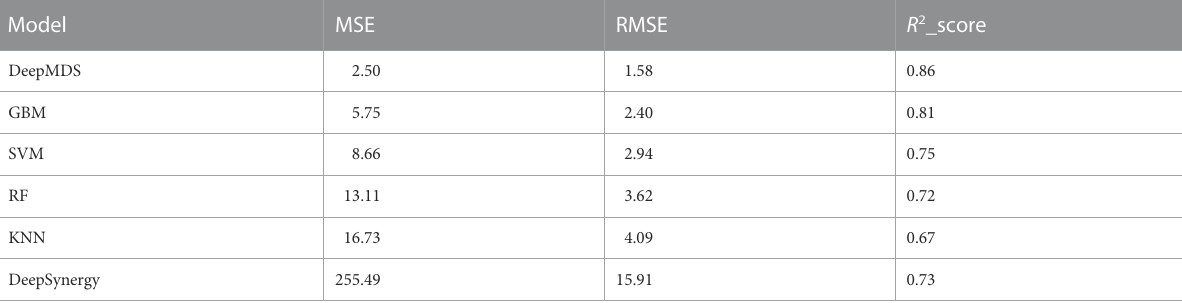
TABLE 2 Model performances of prediction models for regression task.